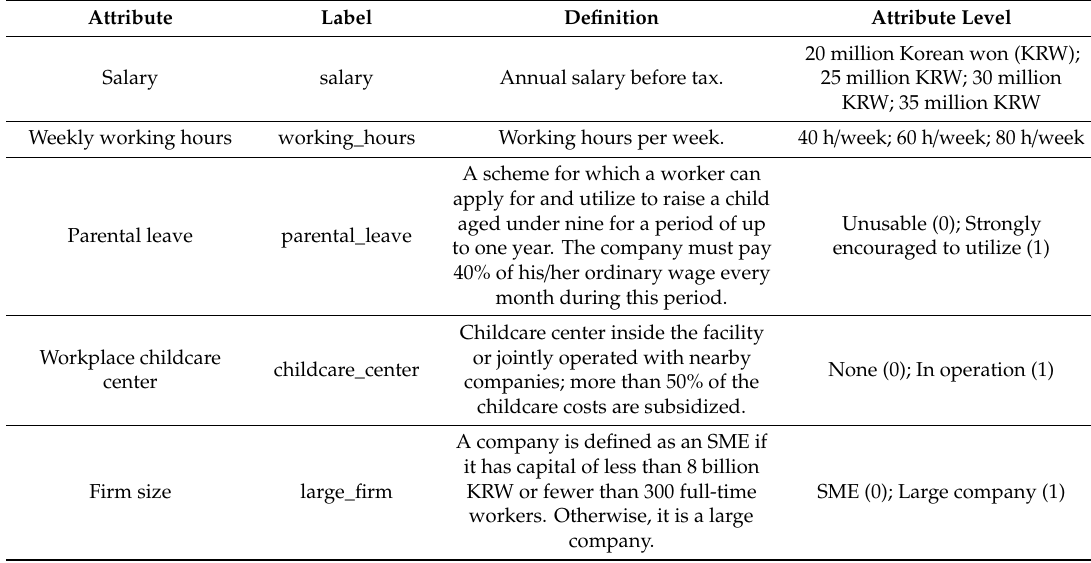
Table 1. Workplace attributes and labels used in the choice